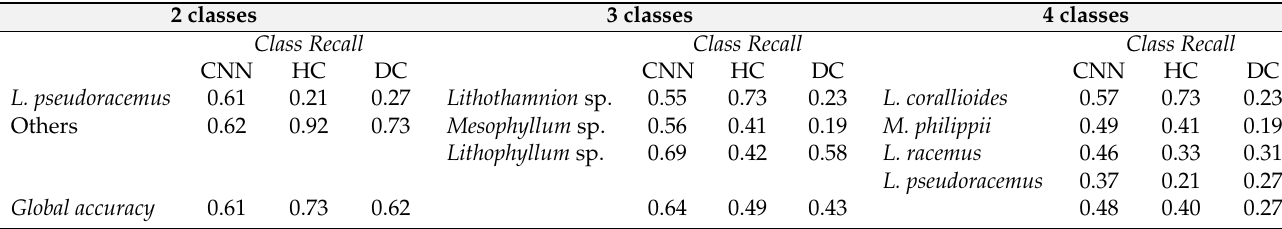
Table 2. Model performances in the 3 classification tasks: L. pseudoracemus versus the other species (2 classes); diverse genera (3 classes) and diverse species (4 classes). The Global accuracy is shown, as well as the Class Recall for each class for the proposed approach (CNN), for the human classifier (HC) and dummy classifiers